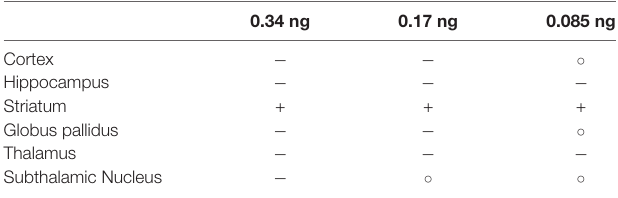
TABLE 1 | Effects on neuronal firing rate in different brain structures after microiontophoretic administration of three amounts of